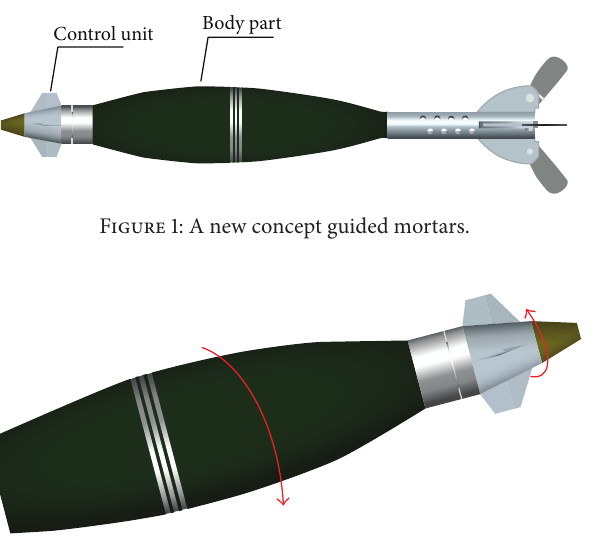
Figure 2: Direction of rotation for guidance kit and shell.